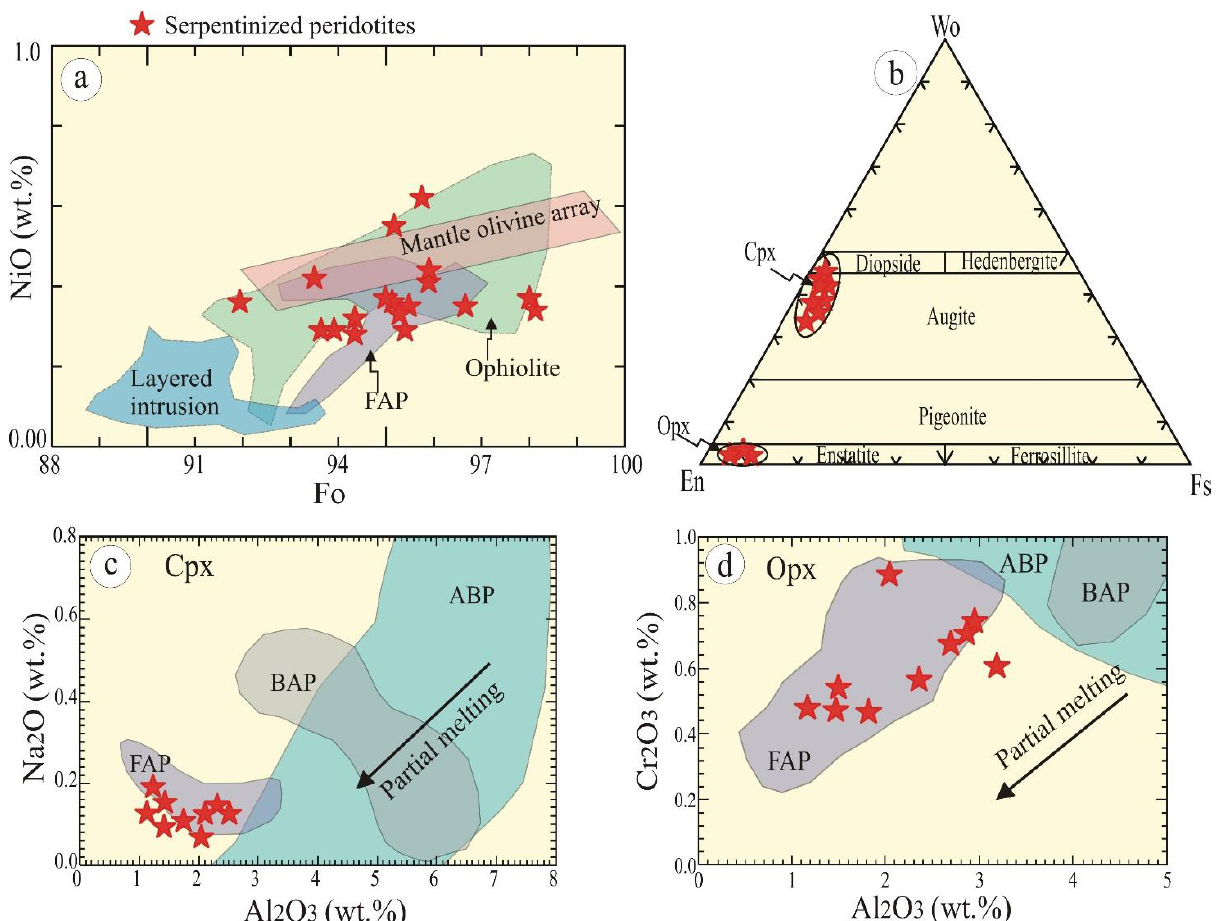
Figure 4. ( a ) Fo vs. NiO binary variation of olivines. Fields of olivine mantle array [27], ophiolite [22], forearc peridotite (FAP) [24], and layered intrusions [7]. ( b ) Enstatite (En)–ferrosilite (Fs)–wollastonite (Wo) nomenclature diagram of pyroxene minerals [23]. ( c ) Na 2 O vs. Al 2 O 3 and ( d ) Cr 2 O 3 vs. Al 2 O 3 binary diagrams [24]. Field of forearc peridotite (FAP) and abyssal basin peridotite (ABP) obtained from [24], and back-arc peridotite (BAP) [28].